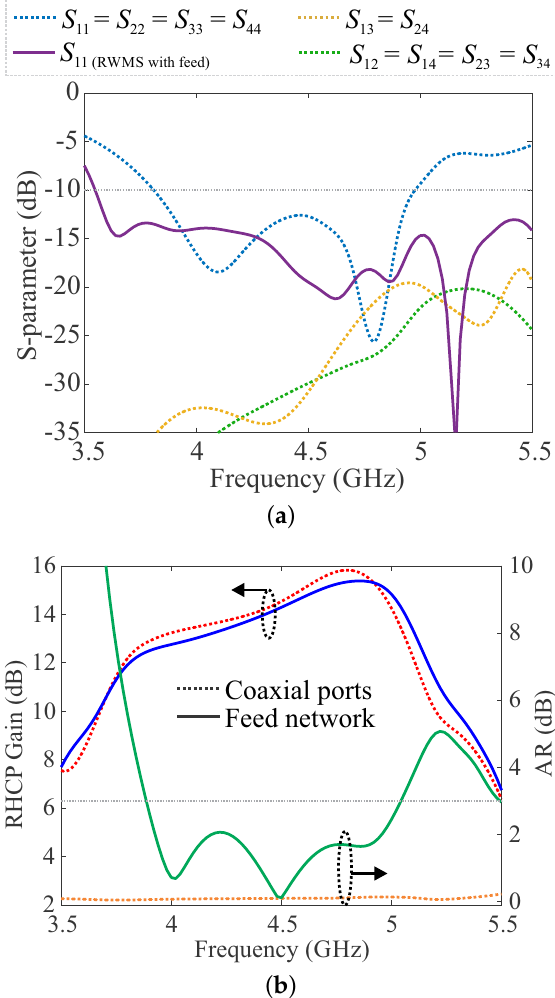
Figure 5. ( a ) S-parameters and ( b ) the broadside RHCP gain along with the axial ratio of the 2 × 2 RWMS